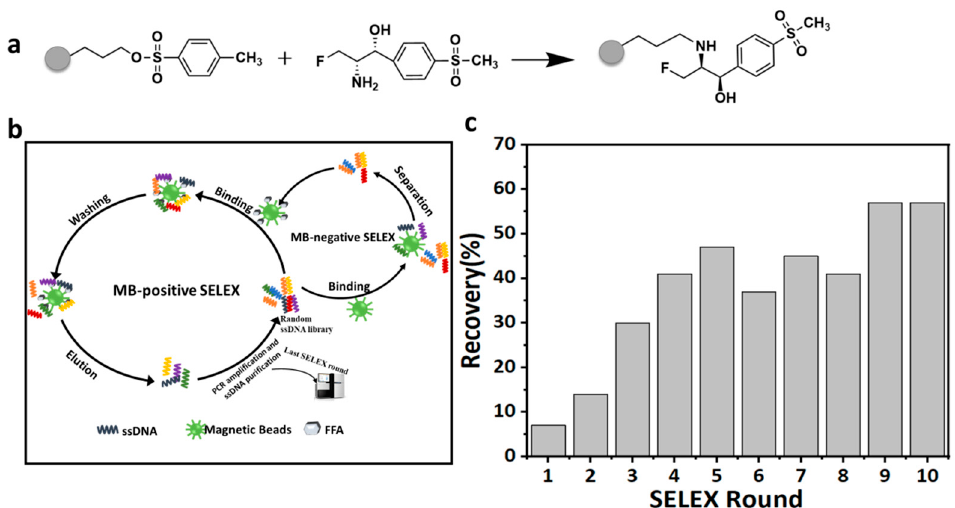
Figure 1. ( a ) The scheme of the covalent coupling of florfenicol amine on tosyl-activated magnetic beads. ( b ) Schematic diagram of MB-SELEX. ( c ) Recovery of ssDNA in the solution in each round of selection.